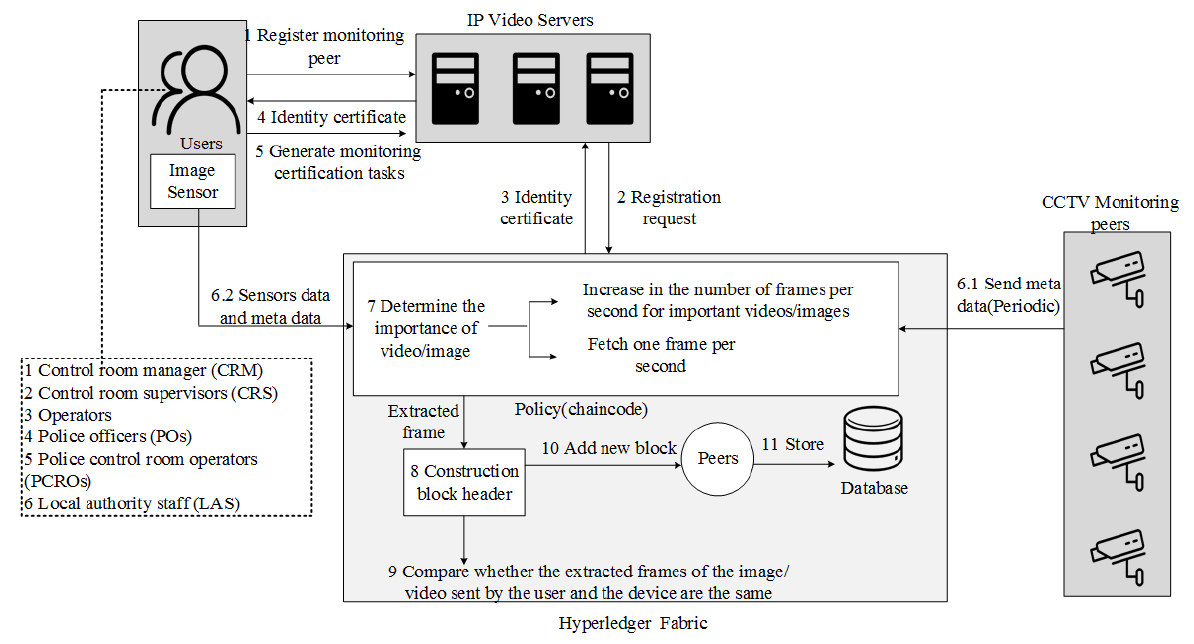
Figure 25. Reconstruction diagram of reference [52].